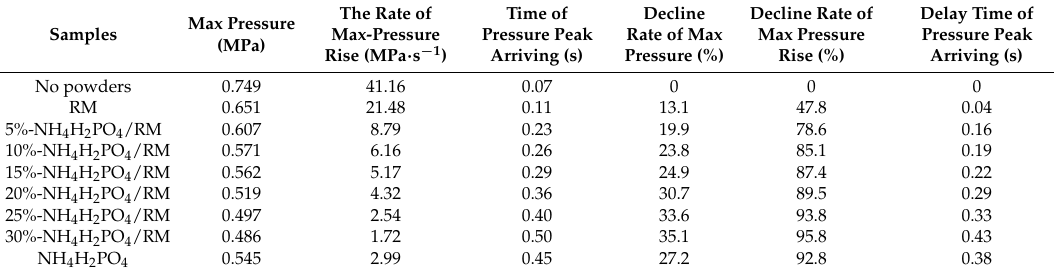
Table 1. The explosion parameters of methane-air premixed gas with different